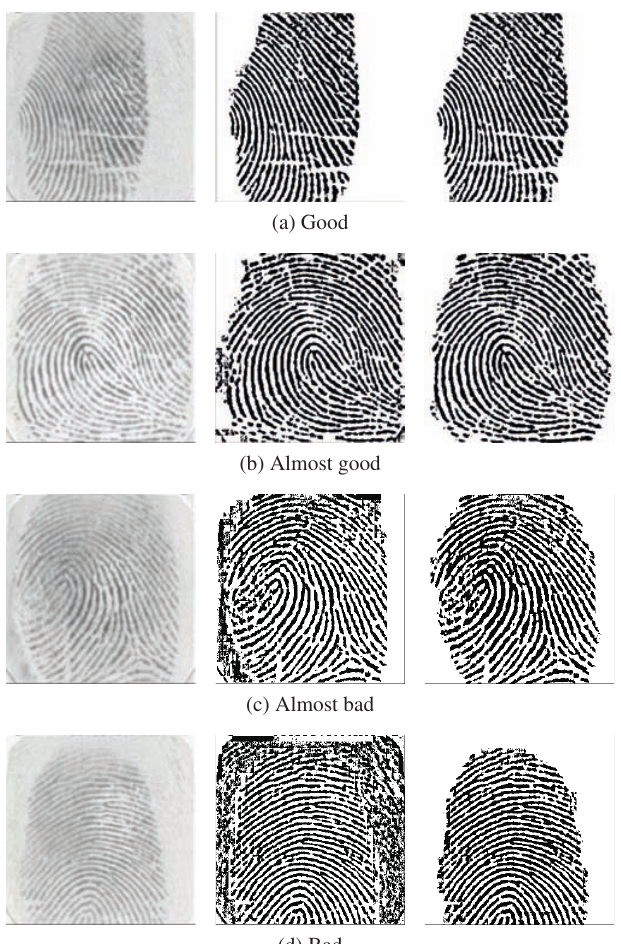
Figure 9. A comparison with the algorithm described by [7]. Left-hand column: the original images. Middle column: segmentation from [7]. Right-hand column: results from current